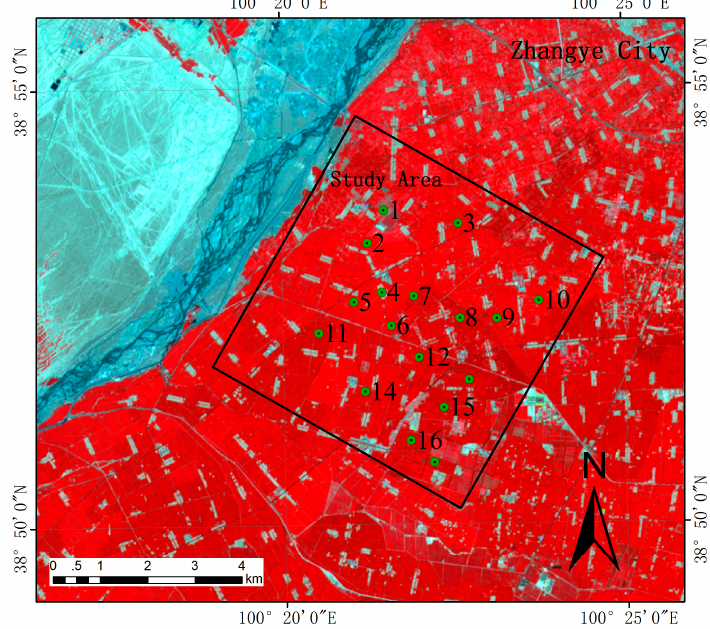
Figure 3. The location of the study area. The green circles represent automatic meteorological stations. The background shows an ASTER false-color VNIR image of the study area taken on 10 July 2012.